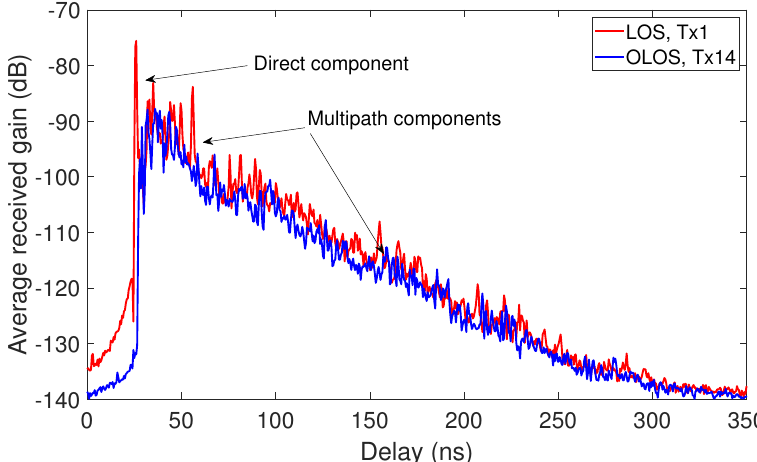
Figure 7. PDP measured in Tx1 and Tx14 positions with LOS and OLOS propagation conditions,